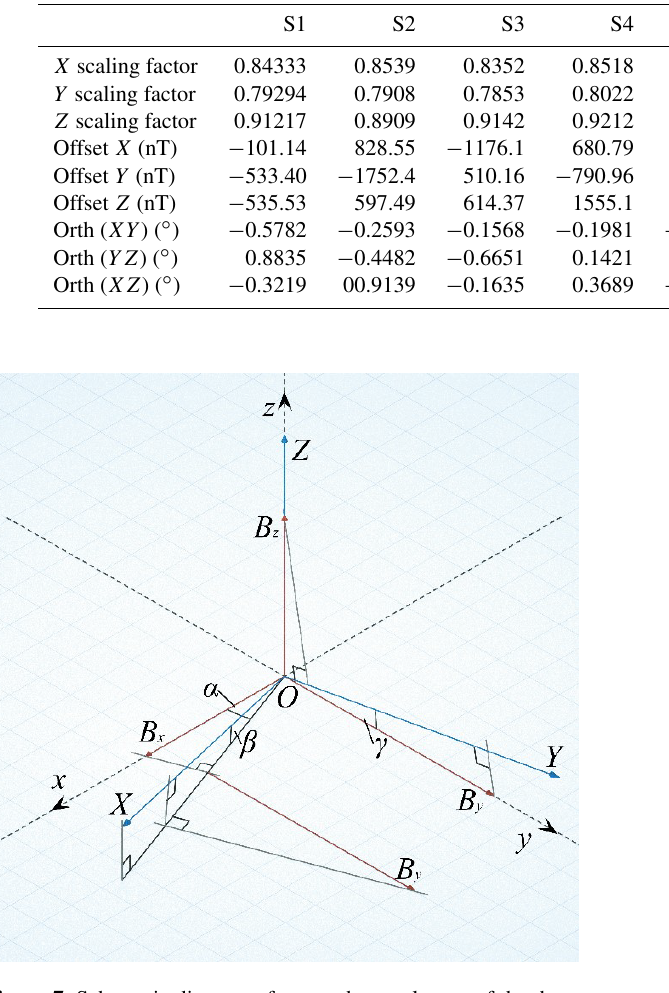
Figure 7. Schematic diagram of non-orthogonal error of the three- axis fluxgate magnetometer. Figure 8. The noise test in a Shielding bucket. (a) The time series of the magnetic field intensity. (b) The corresponding FFT spectrum of the time